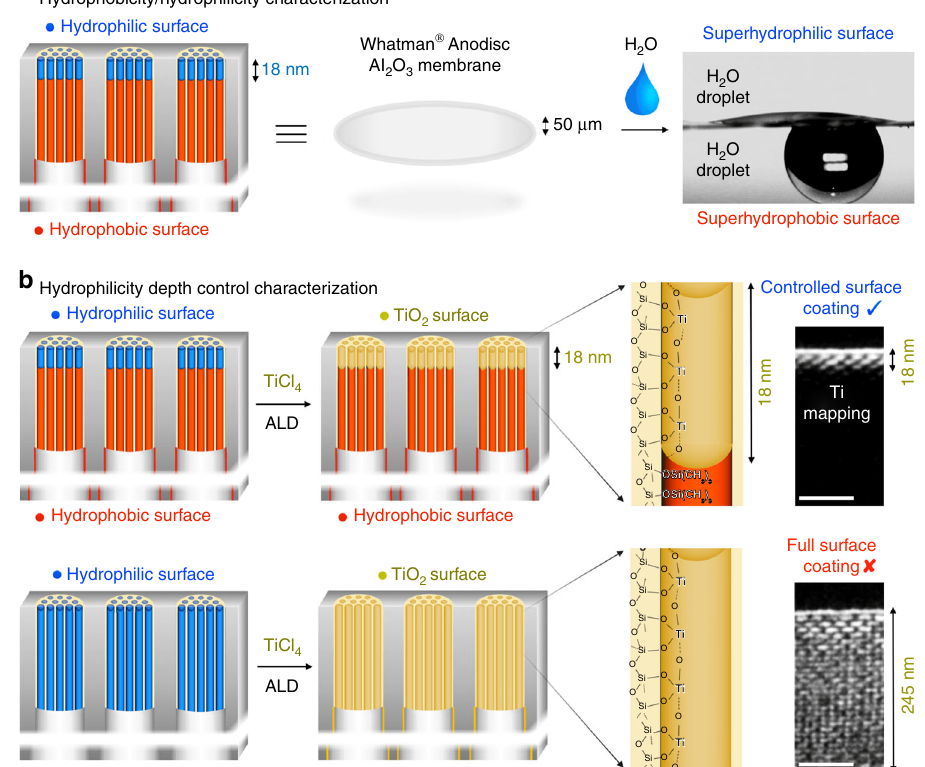
Fig. 5 Hydrophilicity depth characterization of the enzymatic liquid membrane. a Representation of the opposing hydrophilic/phobic character of the membrane surfaces and corresponding water contact angle characterization. b Control experiments designed to probe the hydrophilicity depth of the ‘ amphiphilic ’ membrane. The hydrophilic surface modi fi ed membrane (top row) showed a limited (18-nm-deep) atomic layer deposition (ALD) of titanium oxide (TiO 2 ), mapping the depth of silanol groups (scale bar: 50 nm). In contrast, the fully hydrophilic membrane (bottom row) shows TiO 2 deposition throughout its thickness. The effective membrane thickness of the enzymatic water-membrane for CO 2 capture and separation is thus determined to